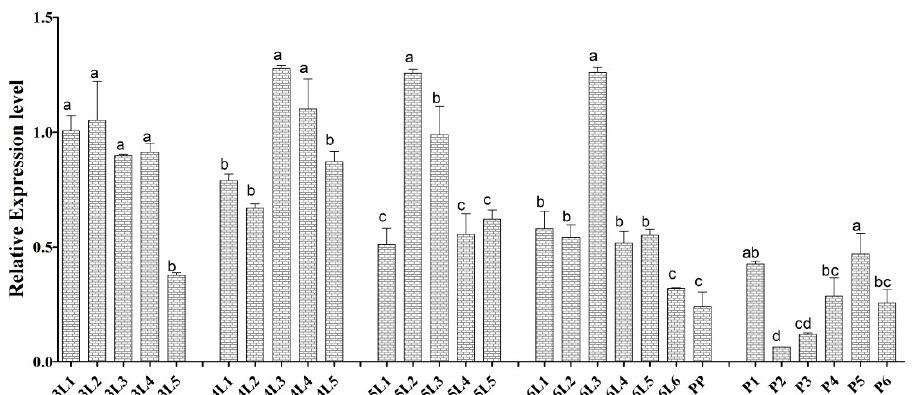
Figure 5. The relative Cs-phm transcript level measured throughout 3rd- to 6th-instar larvae and pupae after 24 h intervals using qRT-PCR. The columns indicate average values, and vertical bars represent SE. Different letters indicate significant differences at p value < 0.05.